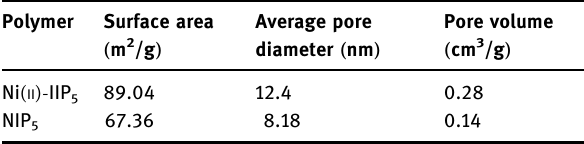
Table 4: Nitrogen adsorption data of Ni ( II )- IIP 5 and NIP 5 Polymer Surface area ( m 2 /g